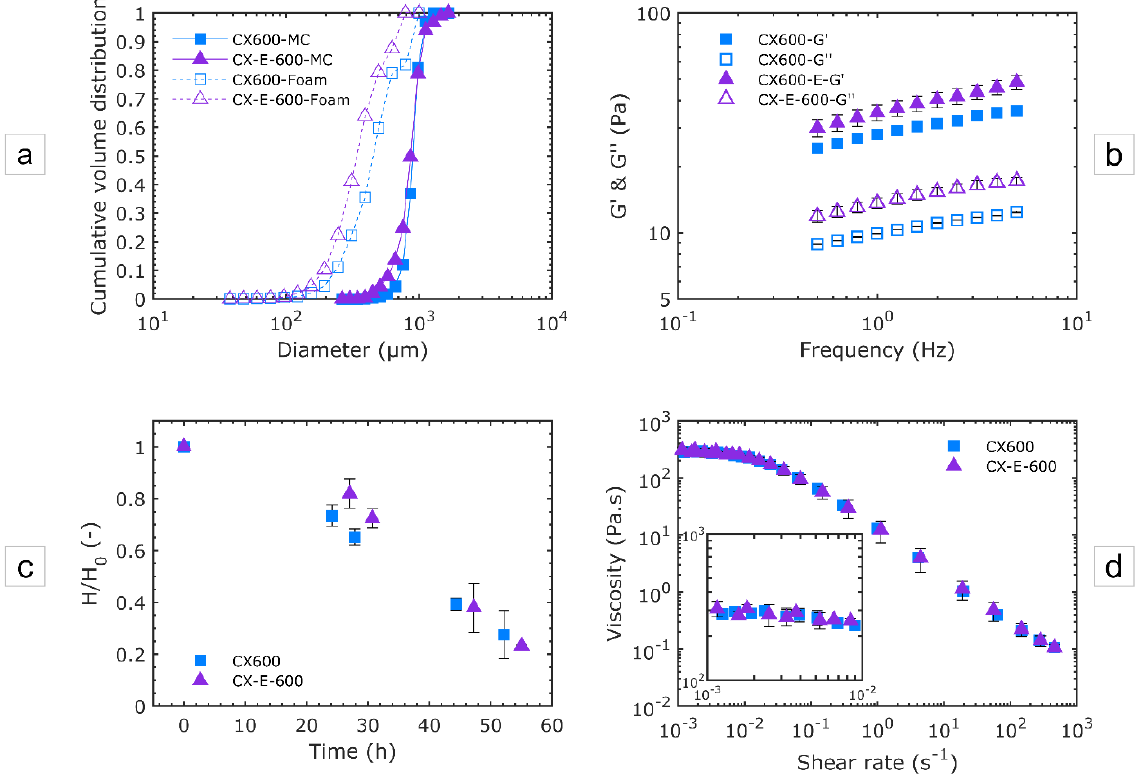
Figure 8. Effect of the expansion channel (CX-E-600 vs. CX600) on the structural and end-used properties of foams produced with the model solution WPI3XG04 at Q vL = 11 L · h − 1 and Q mG = 21.6 g · h − 1 . ( a ) Bubble size distributions in cumulative volume in the mixing channel (MC) and in the end product (foam). The diameters of bubbles inside the microchannels are normalized to the atmospheric pressure. ( b ) Mechanical moduli of foams at 20 ◦ C. ( c ) Stability of foams. ( d ) Viscosity characterization of foams at 20 ◦ C.